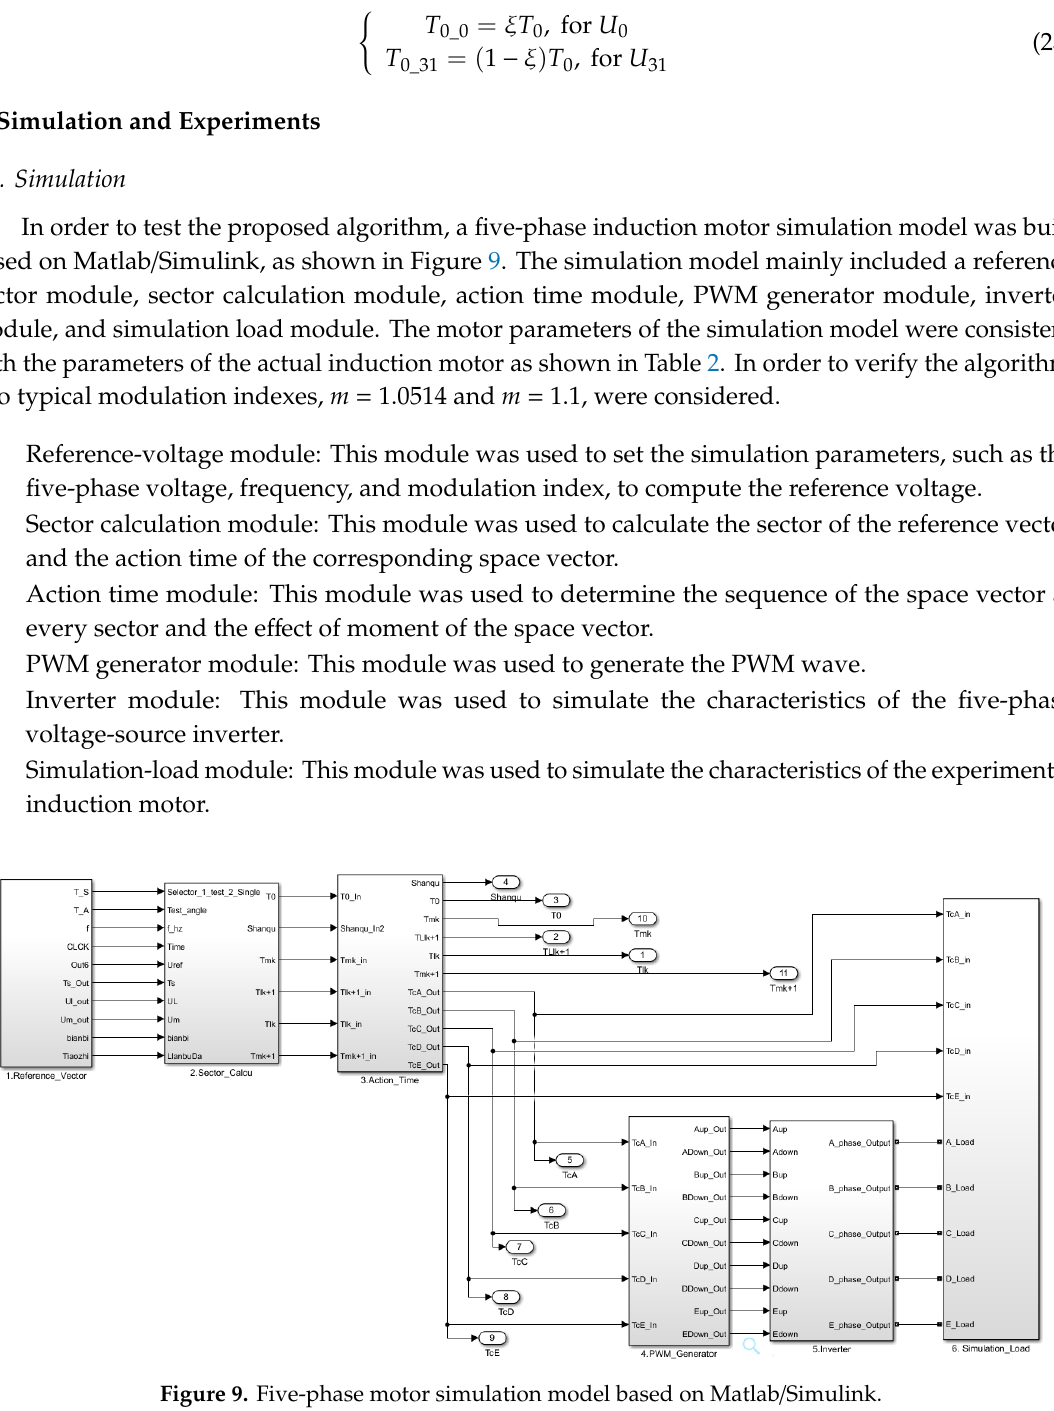
Figure 9. Five-phase motor simulation model based on Matlab/Simulink.